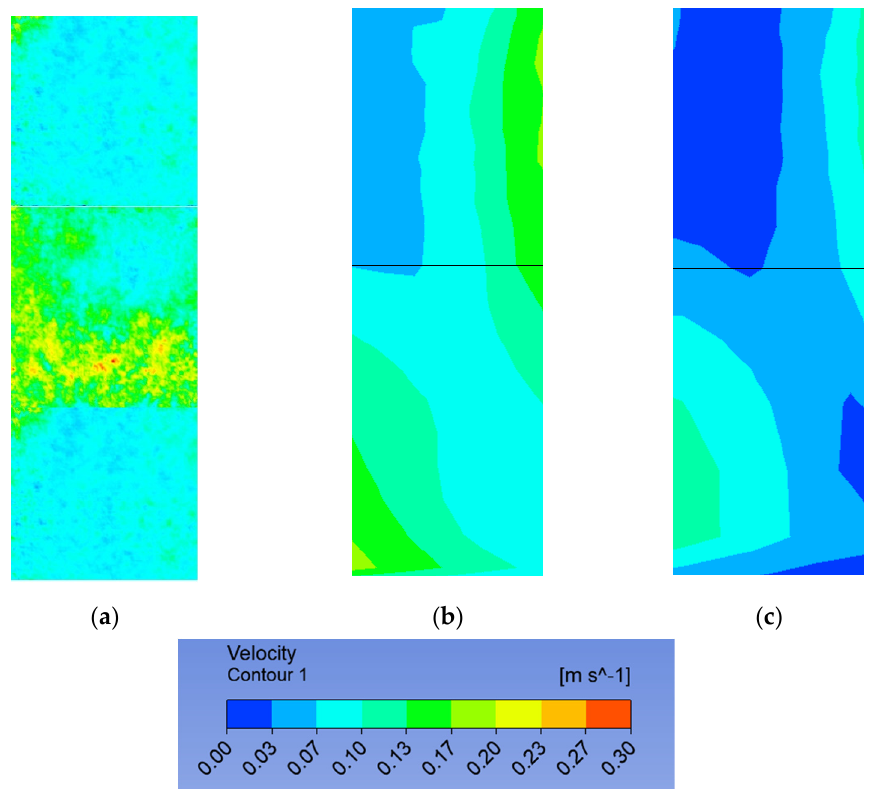
Figure 15. Comparison of air velocity profiles above the operating table: ( a ) measurement by the PIV method; ( b ) model k- ω ; ( c ) model k- ε .